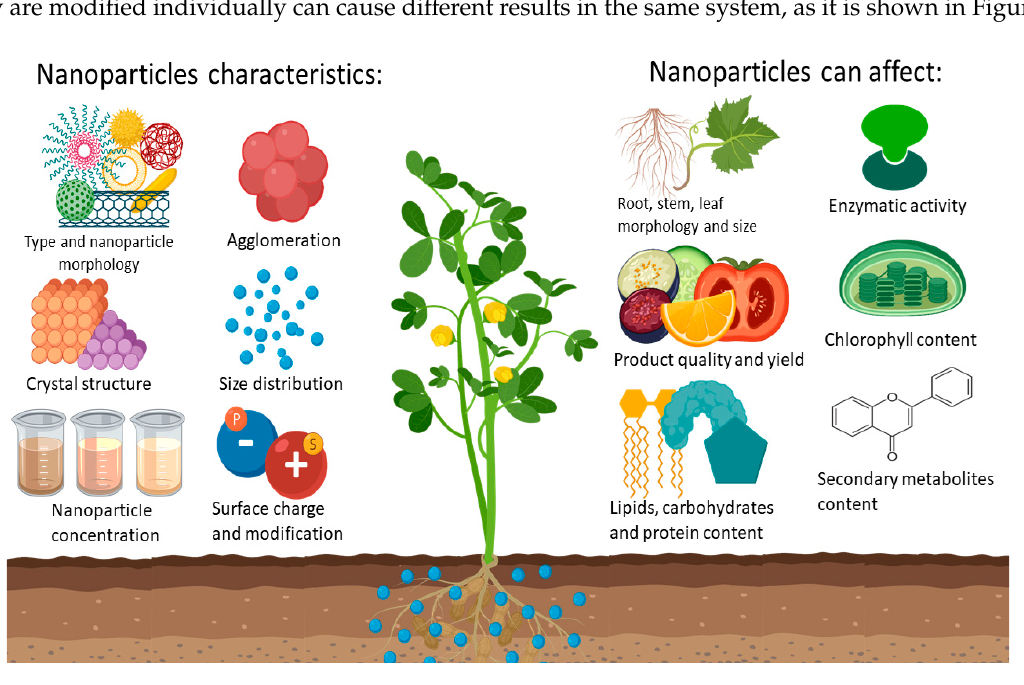
Figure 1. Main characteristics of the nanomaterials and the possible toxicological e ff ects they can induce in